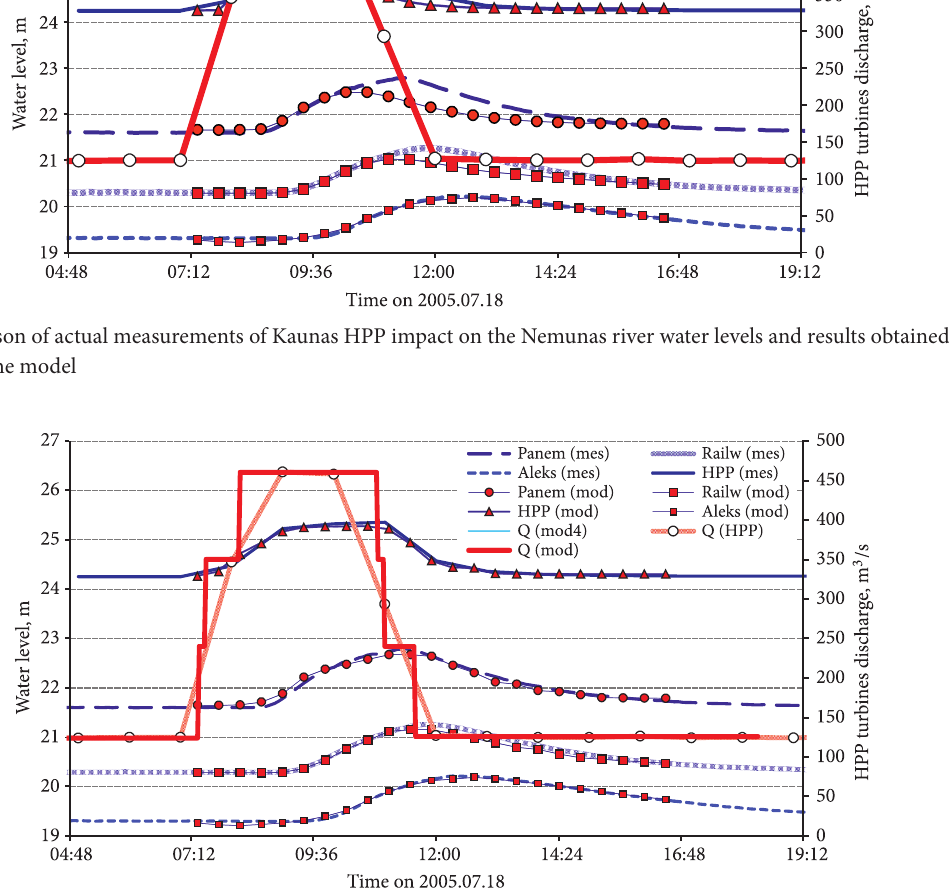
Fig. 8. Comparison of actual measurements of Kaunas HPP impact on the Nemunas River water levels and results obtained from the 2 nd stage of the